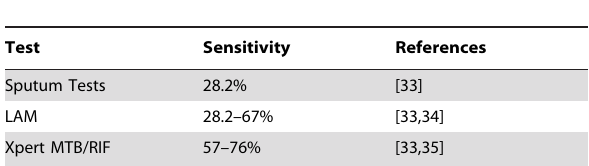
Table 5. Summary of TB Diagnostic Tests.